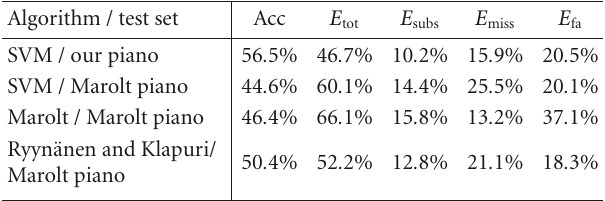
Table 3: Frame-level transcription results on recorded piano only (ours and Marolt test